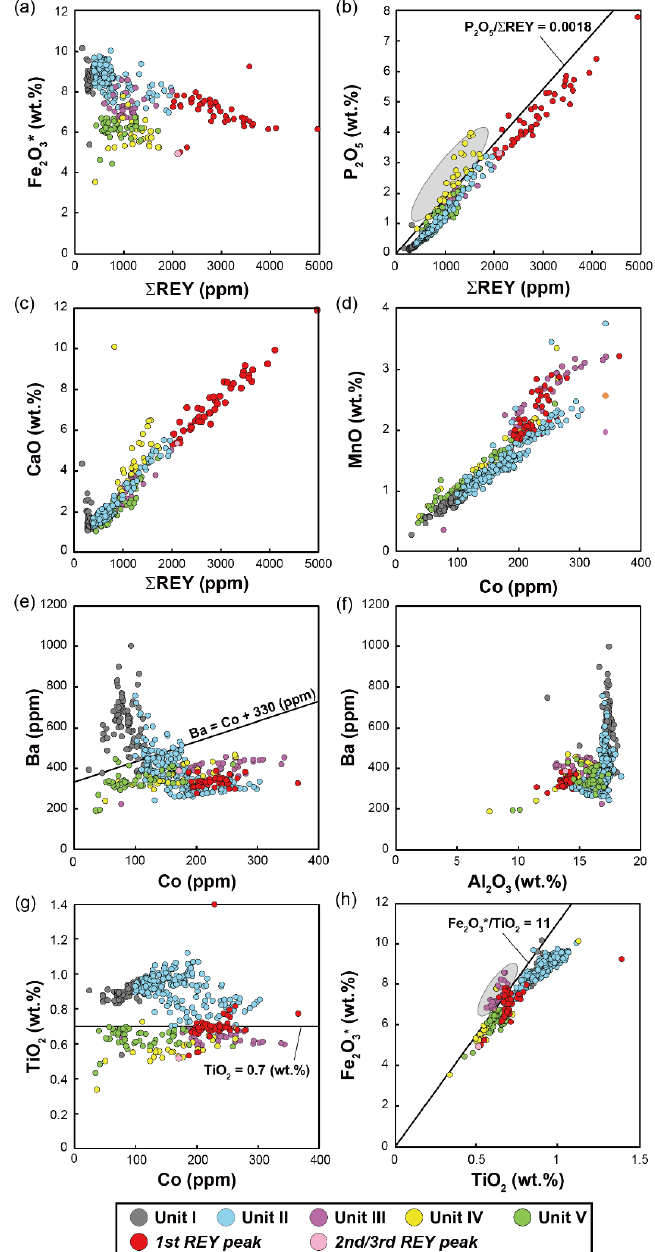
Figure 4. Representative scatter diagrams of sample data color-coded on the basis of the chemostratigraphic scheme established in this study (Section 4.2): ( a ) ΣREY vs. Fe 2 O 3 *, ( b ) ΣREY vs. P 2 O 5 , ( c ) ΣREY vs. CaO, ( d ) Co vs. MnO, ( e ) Co vs. Ba, ( f ) Al 2 O 3 vs. Ba, ( g ) Co vs. TiO 2 , and ( h ) TiO 2 vs. Fe 2 O 3 *. Fe 2 O 3 * indicates total iron as Fe 2 O 3 measured by X-ray fluorescence (XRF) analysis. The gray